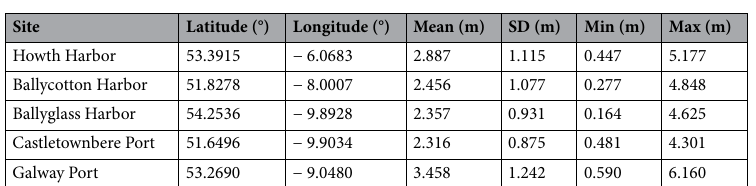
Table 1. Data description of each site.